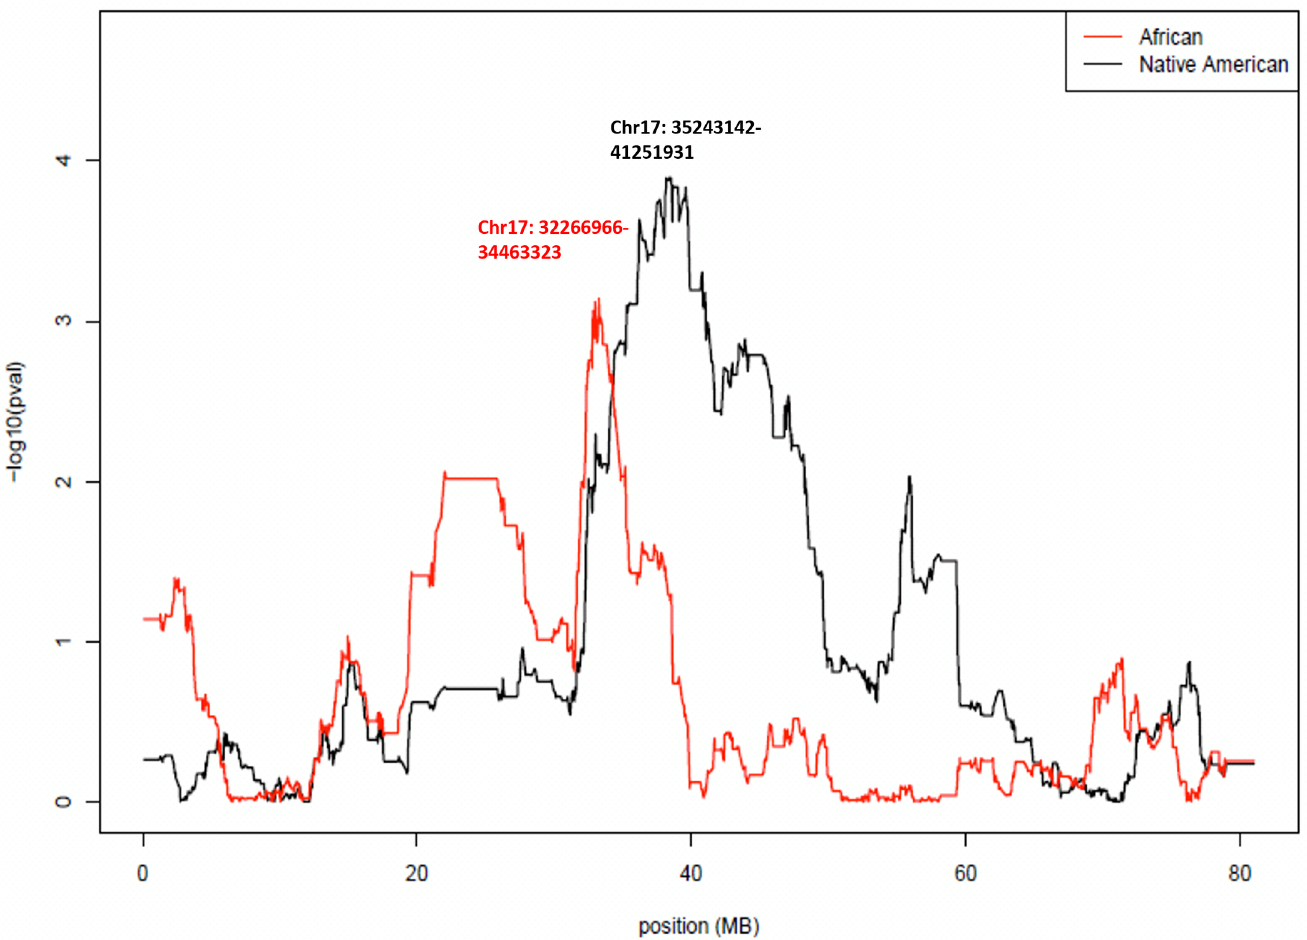
Fig 2. Chromosome 17 regional plot showed peak association between local African/Native Americanancestries and collateralization. Local Native American ancestry was highlyassociatedwith the presenceof collateralsat a region on chromosome17 (35,243,142-41,251,931 (hg19), min P- value = 0.000127, − log10(P-value)= 3.90). Local African ancestry also showed associationwith collateralsat a different regionon chromosome17 (32,266,966-34,463,323 (hg19), min P-value = 0.00072, -log10(P-value)= 3.14). X-axis representedthe base pair location on chromosome 17; Y-axis represented −